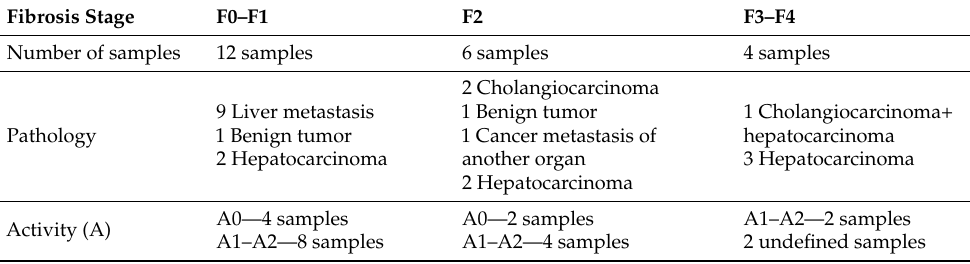
Table 1. Characteristics of the first group of human liver